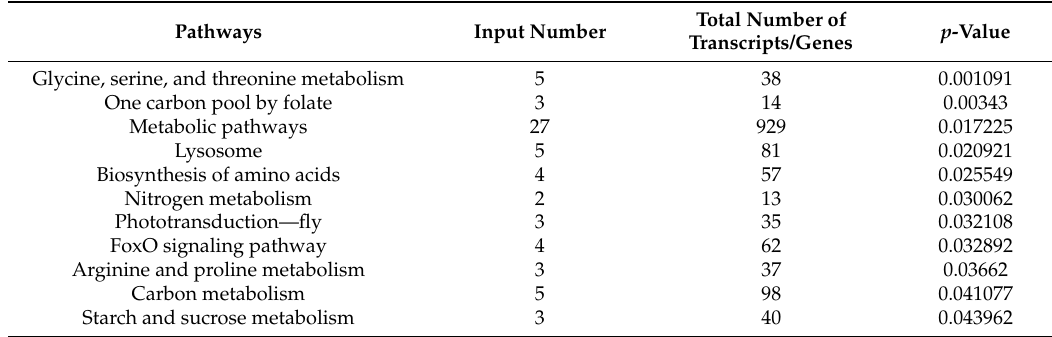
Table 5. Significant pathways of differentially regulated transcripts of salivary gland.